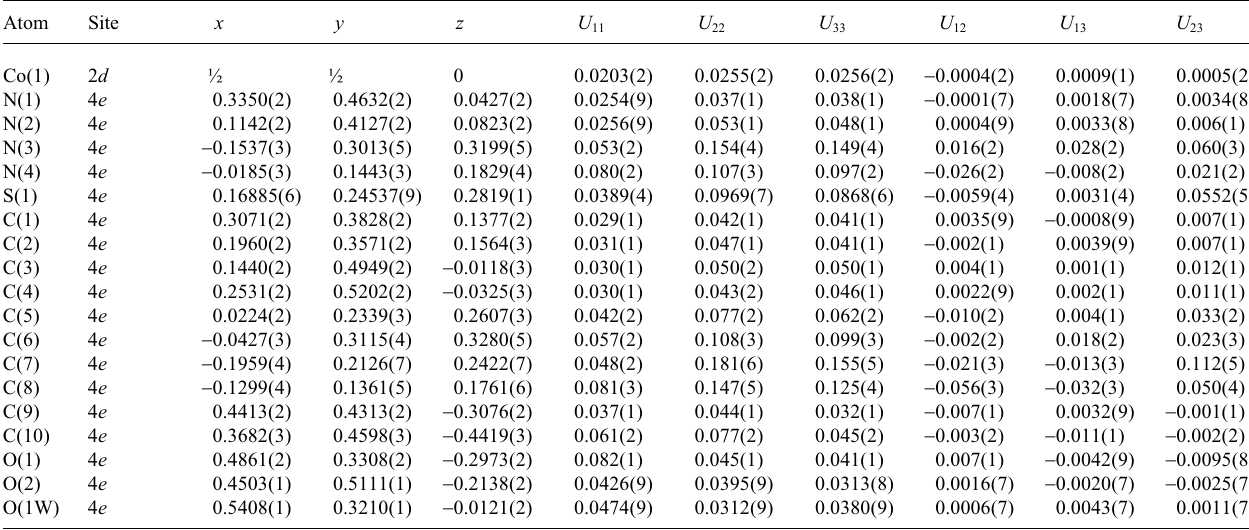
Table 3. Atomic coordinates and displacement parameters (in Å 2 )